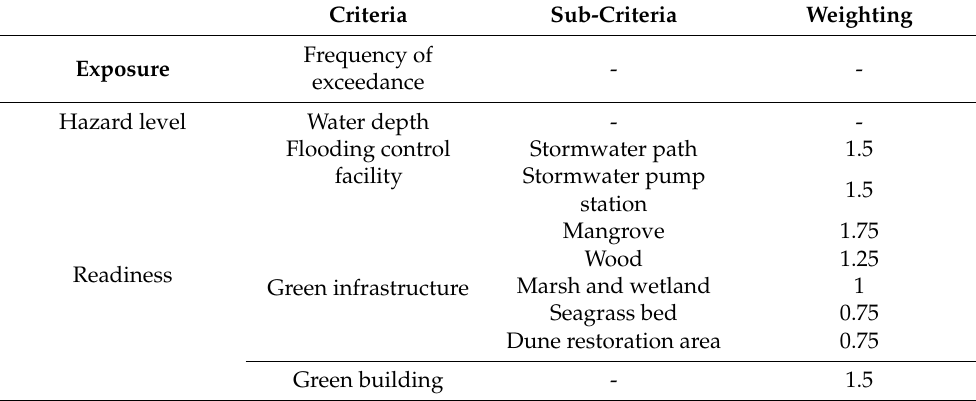
Table 1. Framework for risk